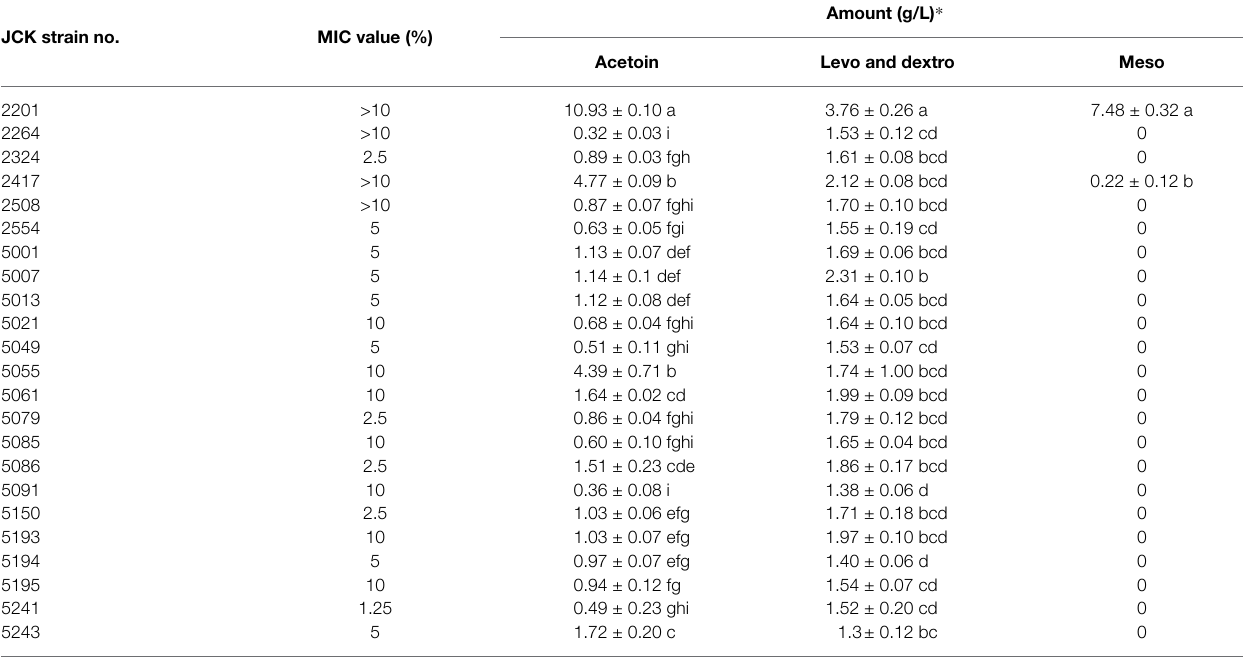
TABLE 1 | Minimum inhibitory concentration (MIC) value against R. solanacearum and 2,3-BDO production amounts by the selected JCK strains.